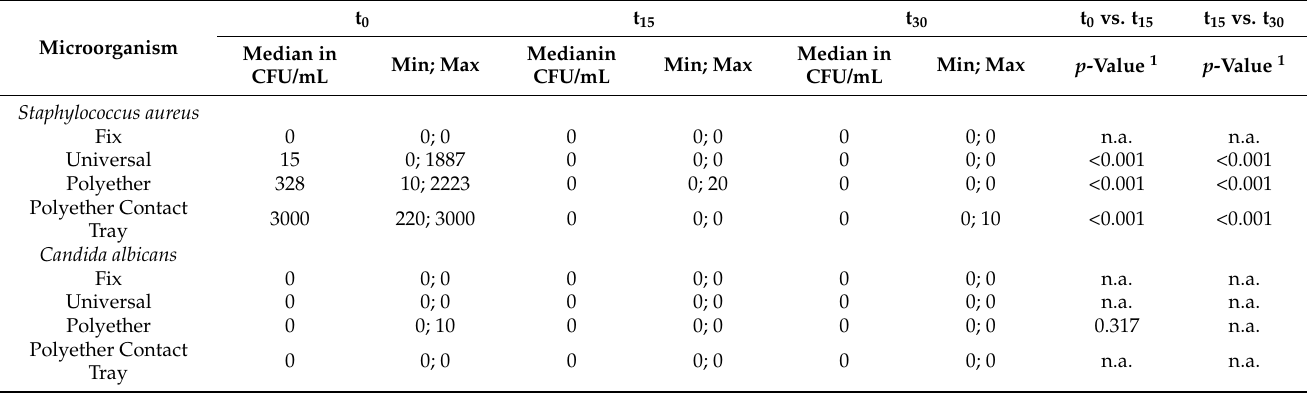
Figure 4. Examples of Staphylococcus aureus on Columbia agar. ( a ) Polyether Adhesive (PA) after 15 min incubation; ( b ) Polyether Contact Tray Adhesive (PCTA) after 30 min incubation. In Universal Adhesive (UA) and Fix Adhesive (FA), no colonies could be detected at both times. Table 1. Agar probes of Staphylococcus aureus and Candida albicans up to 30 min incubation. All other strains showed no